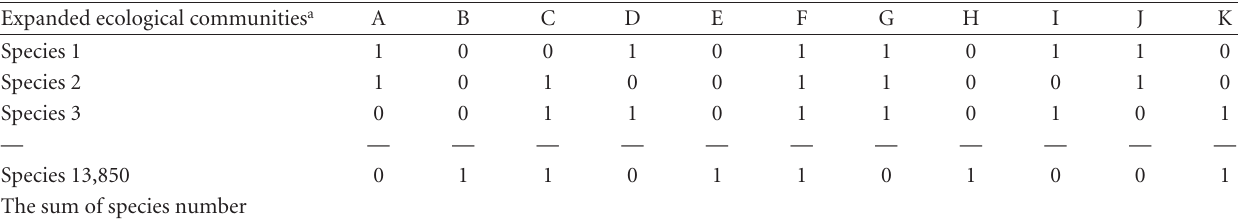
Table 1: Calculation of the number of plant species in each expanded ecological community (flora subregion). Expanded ecological communities a